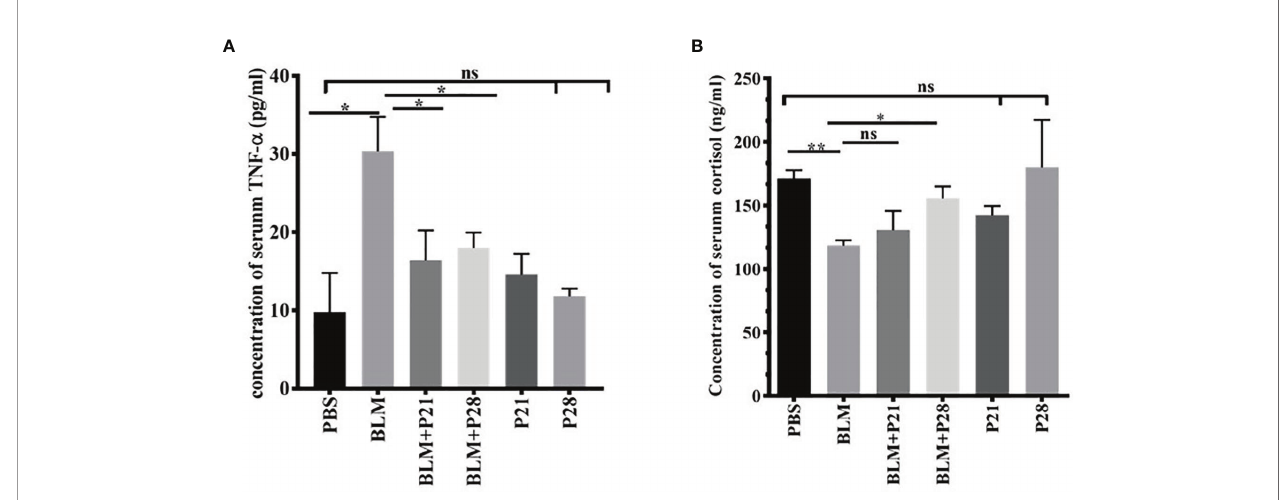
FIGURE 5 | Progesterone is an anti-in fl ammatory agent. Blood was collected on day 29 and sera were separated for measurements. (A) Concentration of serum TNF- a . (B) Concentration of serum cortisol. Results are represented as mean ± SEM, n = 5 mice in each group. Data was analysed with One – way ANOVA, Tukey multiple comparisons test. BLM, Bleomycin; P, Progesterone; ns, non - signi fi cant, ** = P < 0.01, * = P <